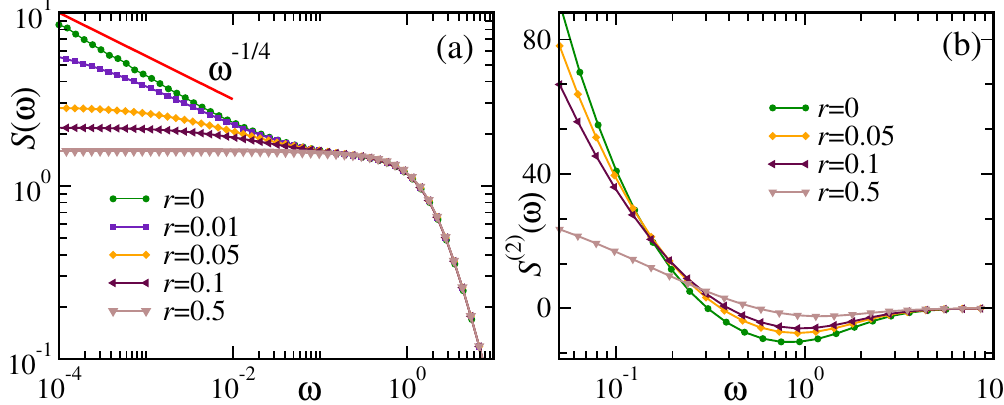
Figure 3: (a) Structure factor S ( ω ) = S ( 0 ) ( ω ) + λ 2 S ( 2 ) ( ω ) [ see Eqs. (15) and (55) ] and (b) leading-order correction S ( 2 ) ( ω ) as functions of ω for a set of values of r and λ = 0.05 in spatial dimension d = 3. At criticality, (i.e., for r = 0) the correction S ( 2 ) ( ω ) (and therefore S ( ω ) ) displays the algebraic singularity predicted by Eq. (57) for ω → 0, which is indicated by the solid line in panel (a). Remarkably, S ( 2 ) ( ω ) becomes negative upon increasing ω above a certain r -dependent value. Here we have used a Gaussian interaction potential V ( z ) = e − z 2 / ( 2 R 2 ) with R = 2. The other = T = D = 1 with κ = parameters are γ 0